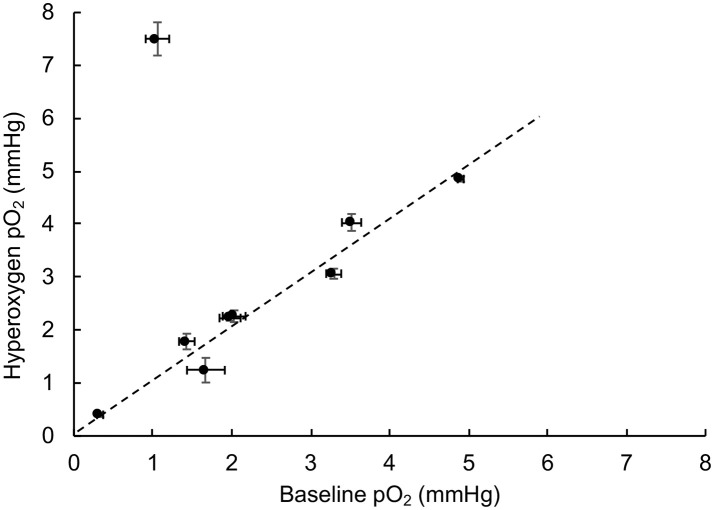
TNBC xenograft tumor does not respond to hyperoxygenation. Oxygen concentration (pO2) in TNBC xenograft tumors was measured during room-air breathing (baseline) and the end of 20 min of hyperoxygenation (100% oxygen) administered via nose-cone breathing. The plot shows the value of hyperoxygen pO2 as a function of baseline pO2. The error bars indicate SEM of measurement in the respective values. The results indicate that all, but one, of the tumors studied (N = 9) do not respond to hyperoxygenation suggesting that the TNBC tumors are not only severely hypoxic, but also resistant to hyperoxic intervention.